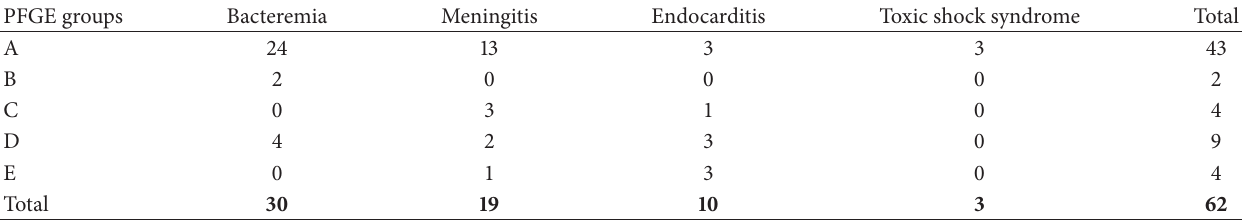
Table 2: Correlation between PFGE groups and S. suis serotype 2